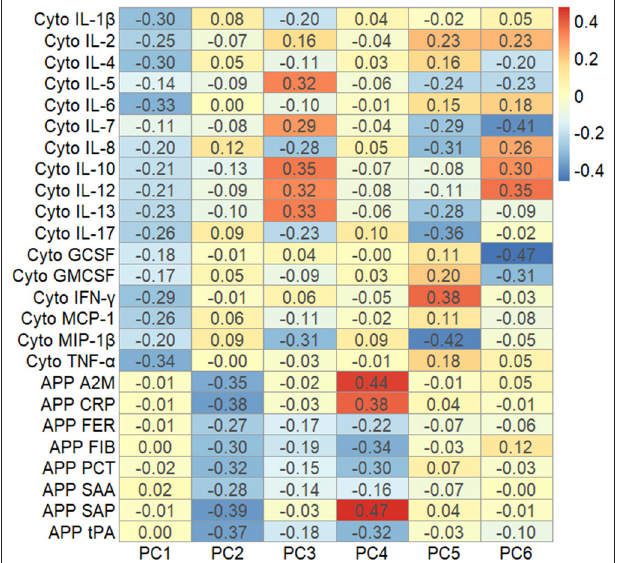
FIGURE 2 | Heat map showing the factor loadings of the six largest principal components (PC1-PC6) derived from the variation in z-scores of all cytokines and acute phase proteins, using samples from mothers to cases and controls drawn in the first trimester of pregnancy ( n 747). A2M, α -2 Macroglobulin; = CRP, C-Reactive Protein; FER, Ferritin; FIB, Fibrinogen; IL-1 β , Interleukin-1 β